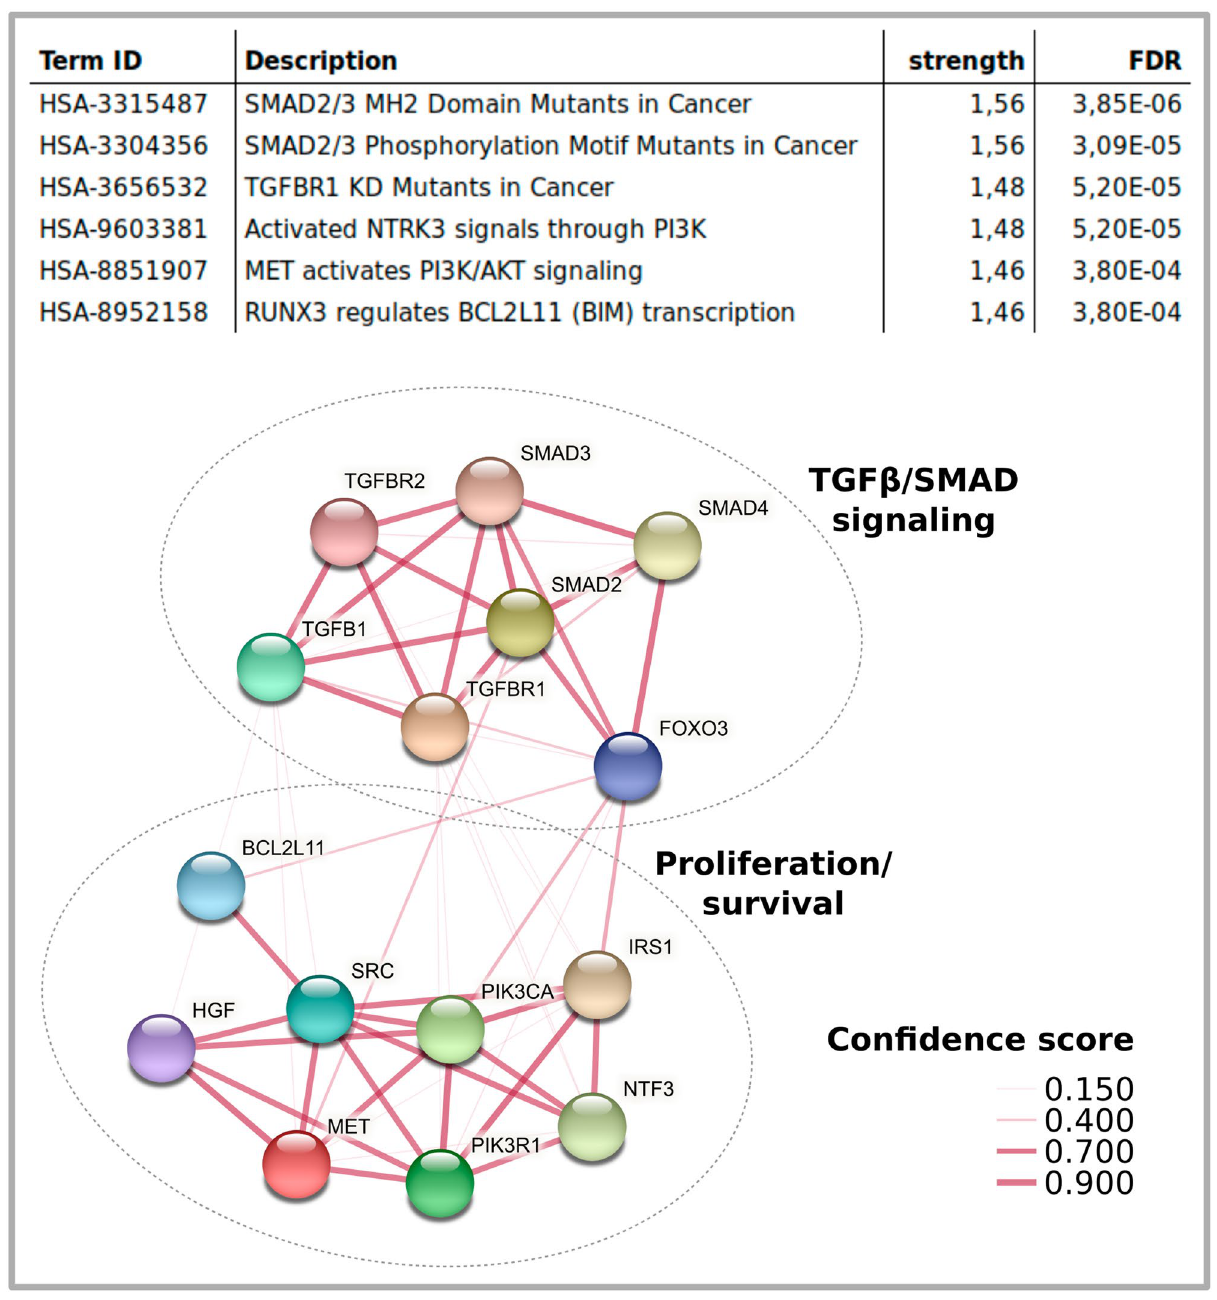
Figure 6. Maximum confidence gene targets of enriched miRNA in hypACT EVs. Reactome pathways presented as physical STRING clusters, line thickness indicates confidence of